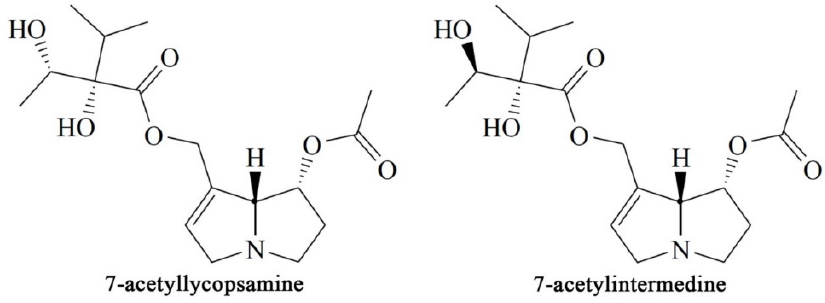
Figure 1. Structures of PAs detected in Chrysanthemum morifolium .